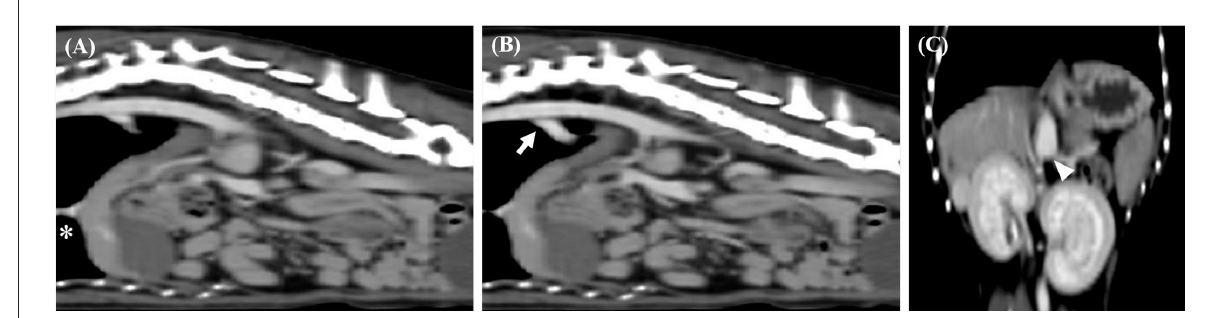
FIGURE1 Sagittal computed tomography images from the late post-contrast series of cases 1. (A,B) Segmental caudal vena cava aplasia (asterisk) and portosystemic shunt (arrow) were observed. Dorsal computed tomography images from the late post-contrast series of cases 1. (C) The white arrow head indicates caudal portion of the shunt.